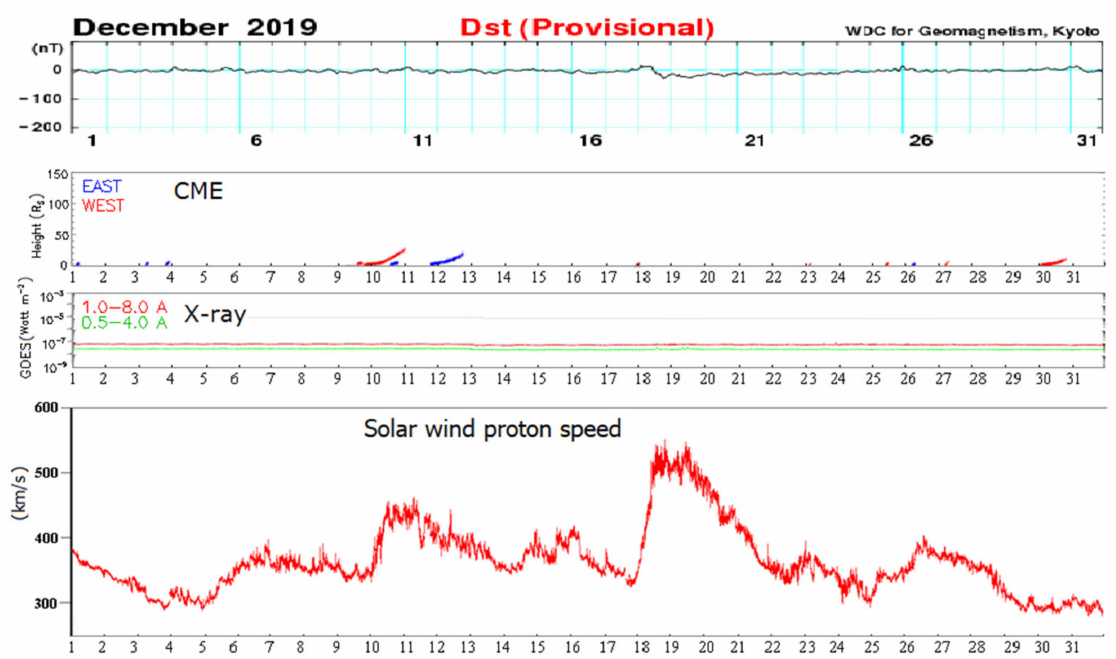
Figure 10. Dynamics of helio geophysical activity in December